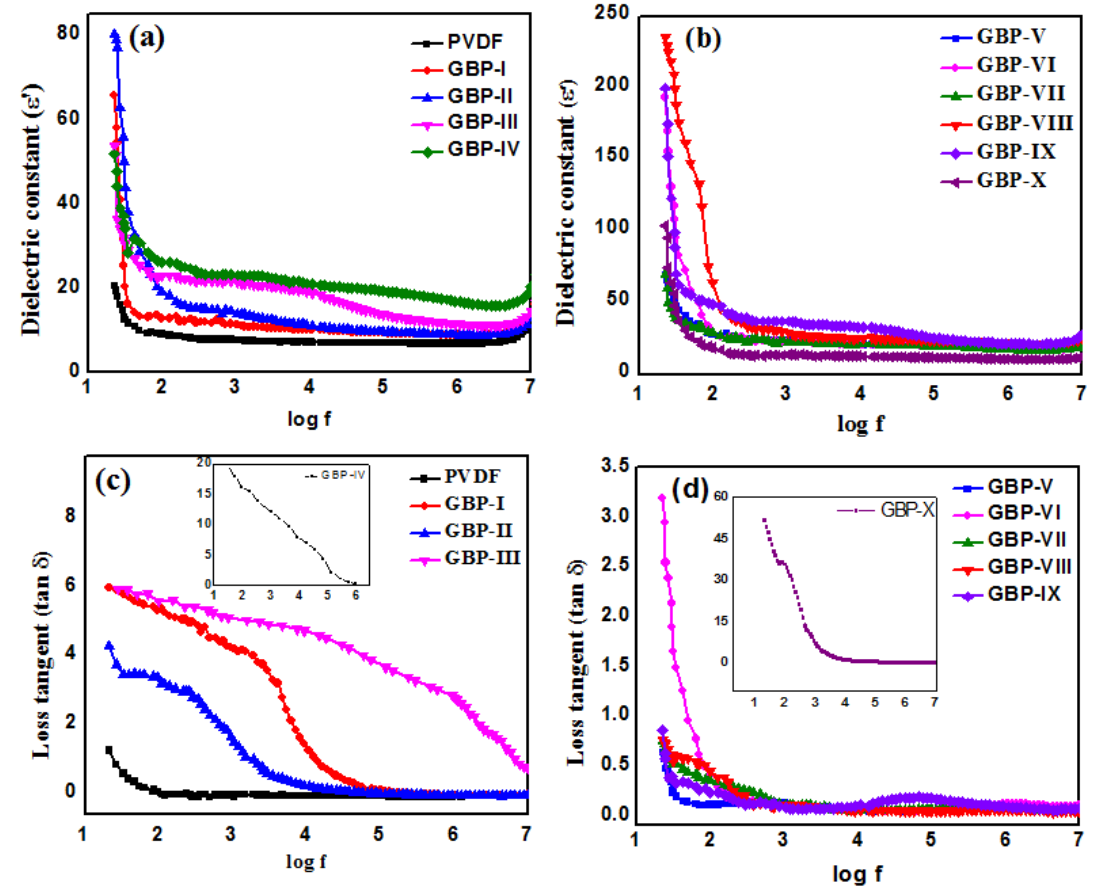
Figure 7. Dielectric constant (ε′) of ( a ) neat PVDF and G/BT/PVDF nanocomposite films with different graphene fraction ( b ) G/BT/PVDF nanocomposite films with different BT fractions. Loss tangent (Tanδ) of ( c ) neat PVDF and G/BT/PVDF nanocomposite films with different graphene fraction ( d ) G/BT/PVDF nanocomposite films with different BT fraction.